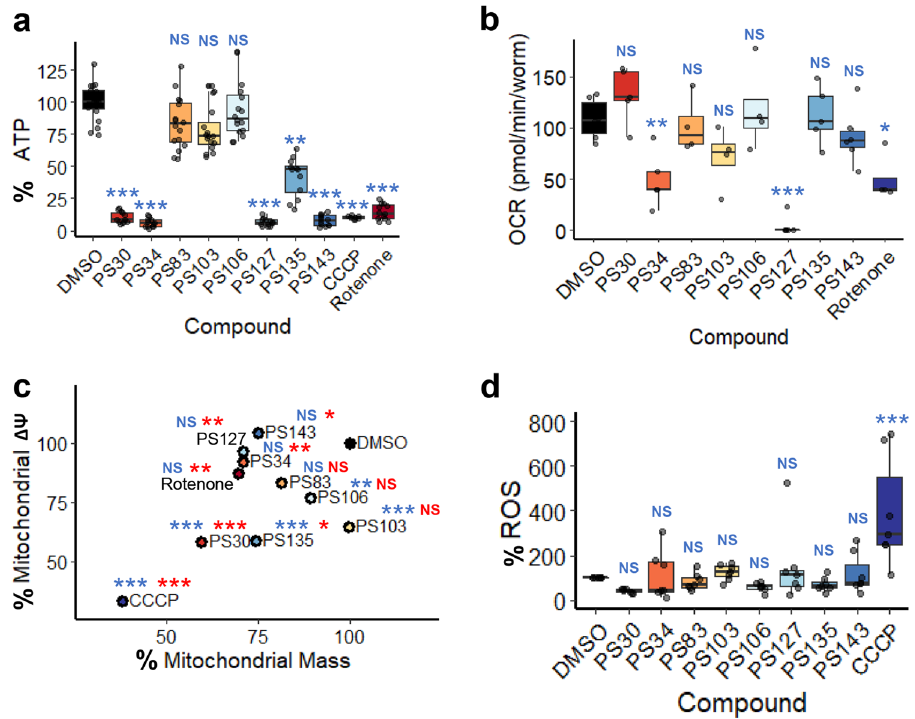
Figure 3. PS compounds differently affected multiple mitochondrial parameters. ( a ) Quantification of luminescence (normalized to GFP) of C. elegans carrying Psur-5 ::luciferase::GFP upon 19 h of treatment with DMSO, PS compounds, CCCP, or rotenone. ( b ) Oxygen consumption rate (pmol/min/worm) measurement of wild-type worms upon 8 h of treatment with PS compounds or rotenone. ( c ) Point plot of MitoTracker Green (mitochondrial mass, x -axis) and MitoTracker Red (mitochondrial membrane potential, y -axis) fluorescence of wild-type worms upon 15 h of treatment with PS compounds or CCCP. ( d ) Quantification of DHE fluorescence upon 15 h of treatment with PS compounds or CCCP. At least three biological replicates with ( a , c , d ) ~ 400 worms/replicate or ( b ) 6000 worms/replicate were analyzed. p -values were determined from one-way ANOVA, followed by Dunnett’s test. For ( a , c , d ), fold-changes were normalized to DMSO control (at 100%). NS not significant, * p < 0.05, ** p < 0.01, *** p < 0.001. In ( c ), blue color indicates significance of change in mitochondrial membrane potential; red indicates significance of change in mitochondrial